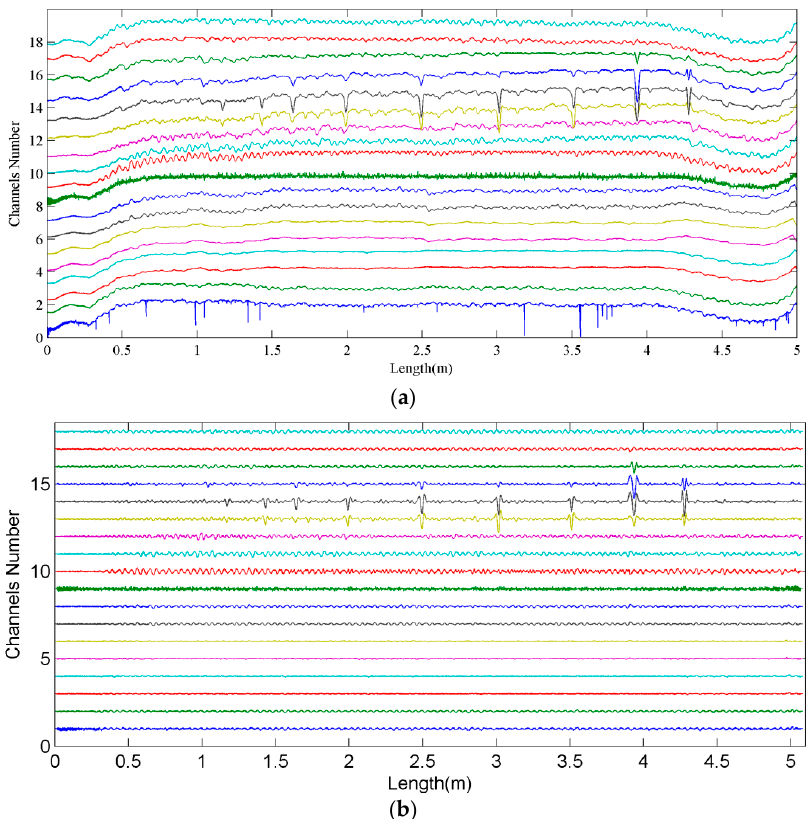
Figure 8. ( a ) Raw remanence signal of 18 channels; ( b ) balanced remanence signal after baseline estimation.